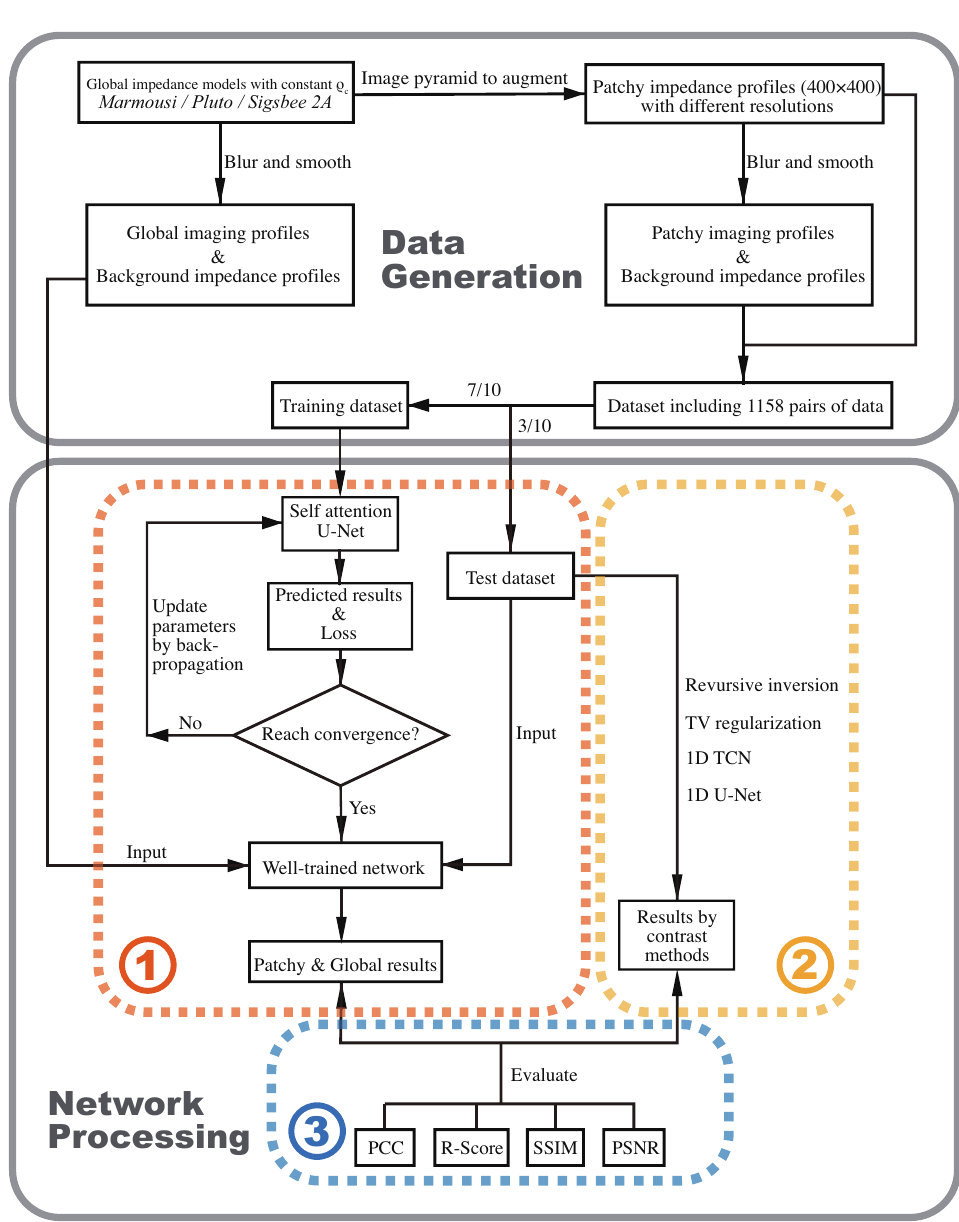
Figure 3. Complete workflow: Including two parts, data generation, and network processing. Network processing has three steps: training, validating, and